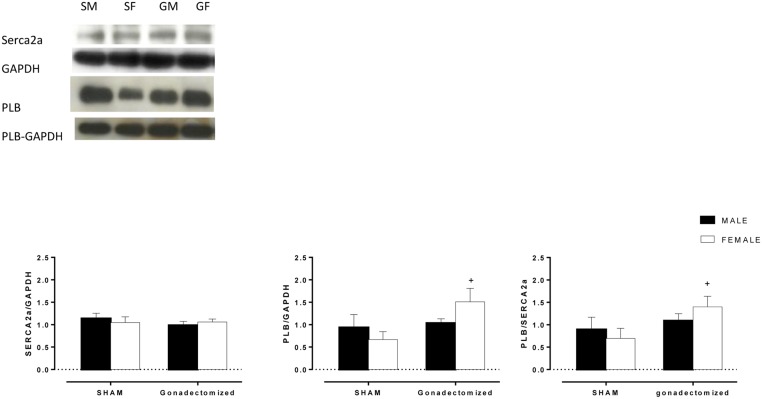
Densitometric analysis of Western blots.(A) SERCA2a; (B) phospholamban (PLB), (C) PLB to SERCA2a ratio, in hearts from male and female sham and gonadectomized rats. (SM: sham male; SF: sham female; GM: gonadectomized male; GF: gonadectomized female). The values are expressed as the means ±S.E.M (n = 6 per group). *P < 0.05 vs. females of the same group; +P < 0.05 vs. sham animals of the same sex (two-way ANOVA and Fischer test).